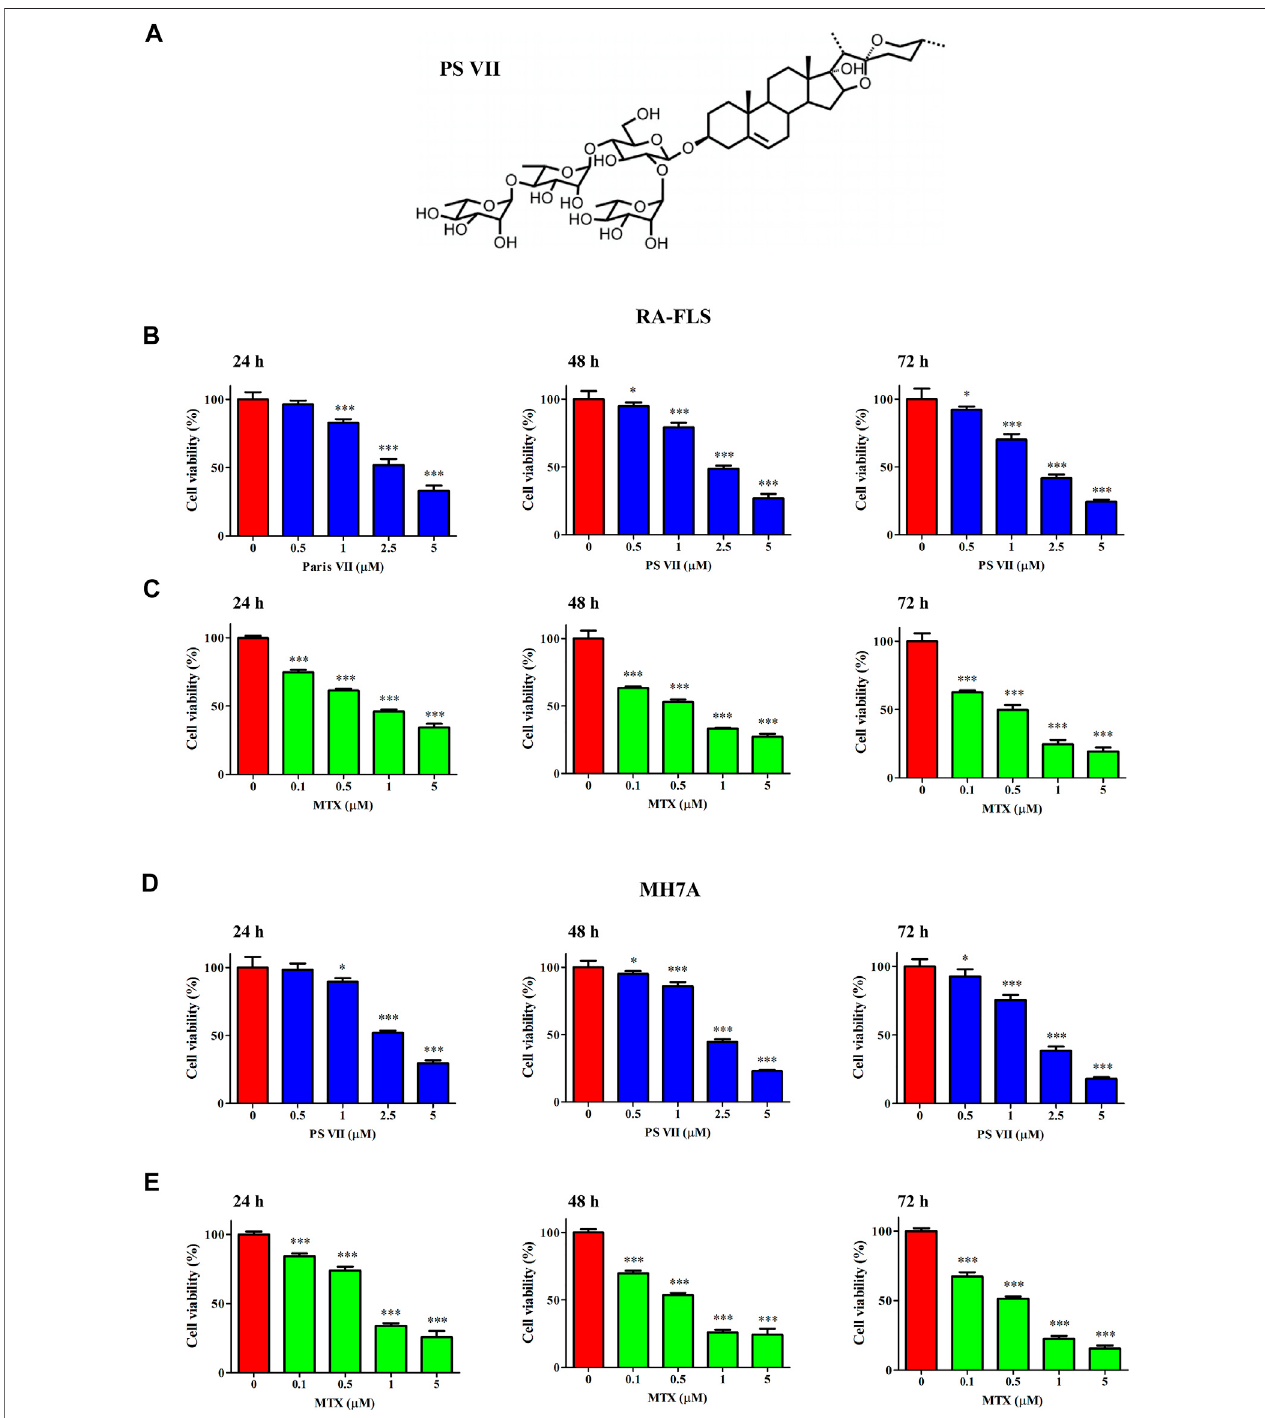
FIGURE1| Effects ofPSVII onthe cellviability ofRA-FLSand MH7Acells. (A) Themolecularstructure ofPSVII. (B, C) Thecell viabilityofRA-FLS wasdetermined by MMT assay after treated with different concentrations of PS VII (0, 0.5, 1, 2.5, 5 μ M) and MTX (0.1, 0.5, 1, and 5 μ M) for 24, 48, 72 h. (D, E) The cell viability of MH7A wasdeterminedbyMTTassaysaftertreatedwithdifferentconcentrationsofPSVII(0,0.5,1,2.5,5 μ M)andMTX(0.1,0.5,1,5 μ M)for24,48,72 h.MTXwastreatedas positive control. Data were expressed as mean ± SD from three independent experiments. * p < 0.05, ** p < 0.01, *** p < 0.001.